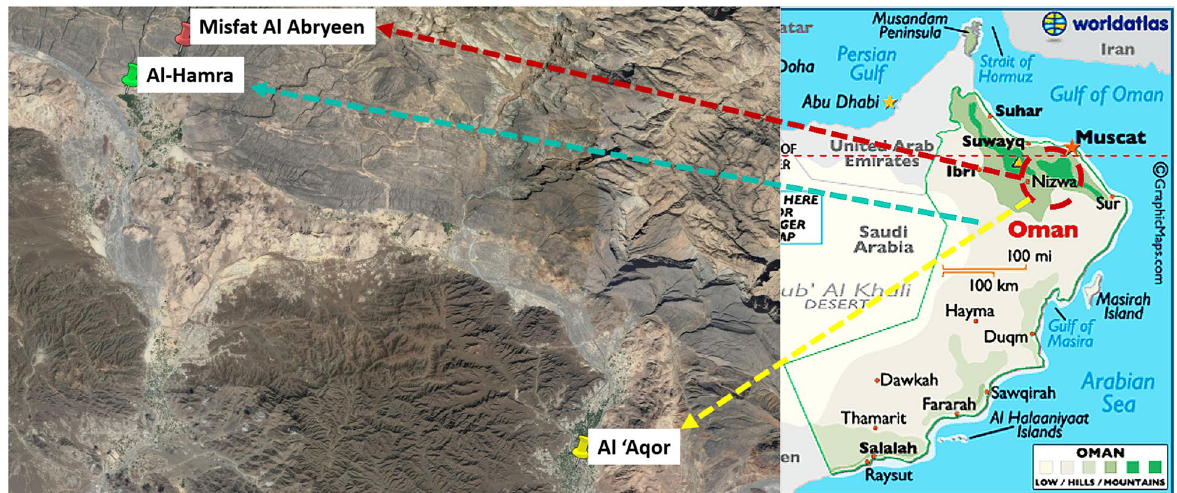
Fig. 3 Location of the three case studies in the region of A-Dakhiliyah (Source: Google Earth image enhanced by the